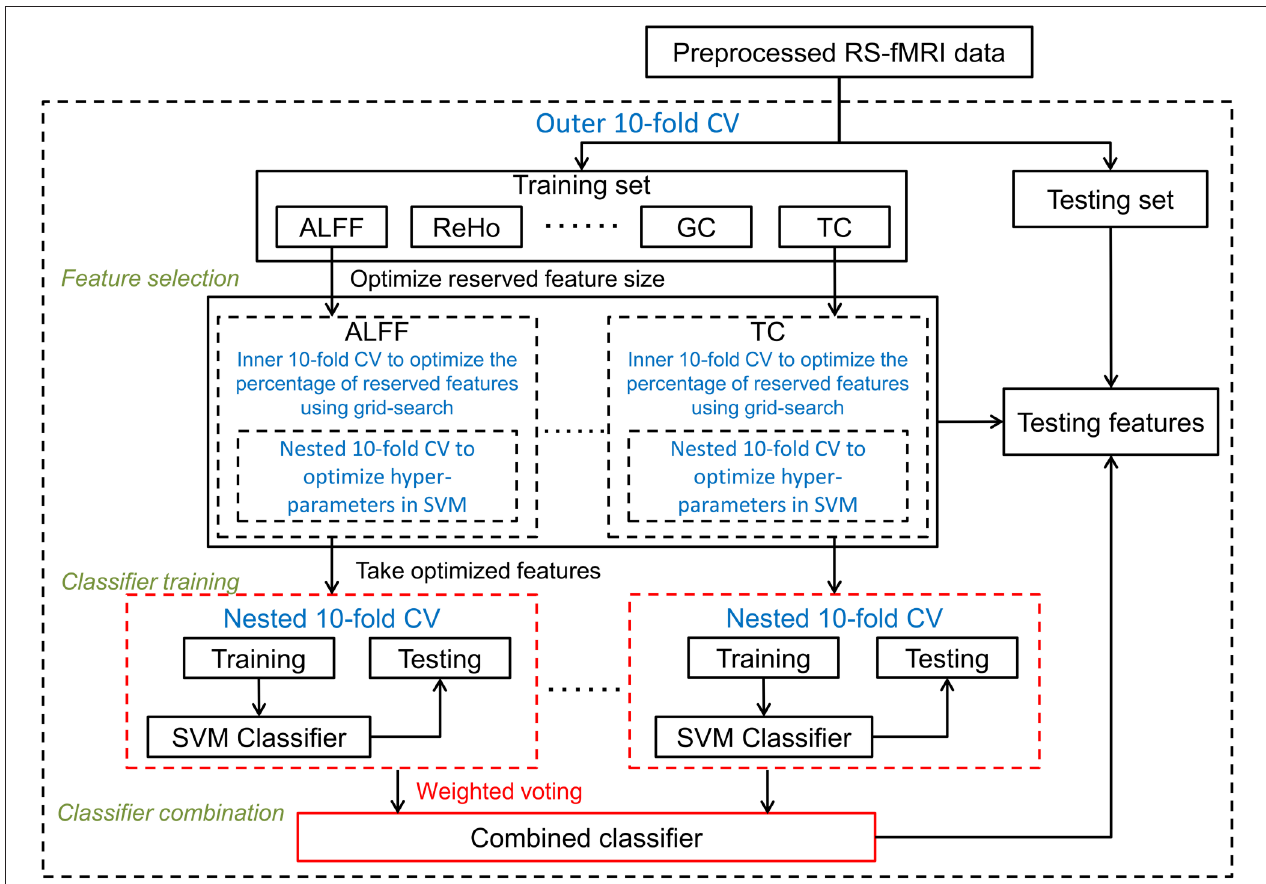
FIGURE 3 | Optimized framework of classifier combination: classifiers were trained separately on each optimized feature set, and a final classifier was then combined using weighted voting. Cross-validation parts are in blue font and dashed lines. To distinguish this combination from other the two frameworks, the classifier combination part is shown in red.